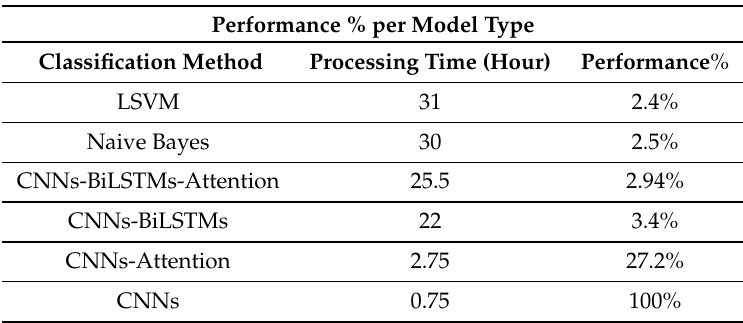
Figure 4. Y axis:Models/Models indices, X axis is the Relative performance for the models based on CNNs performance baseline/Modeling Time. Table 4. Performance-Time Based